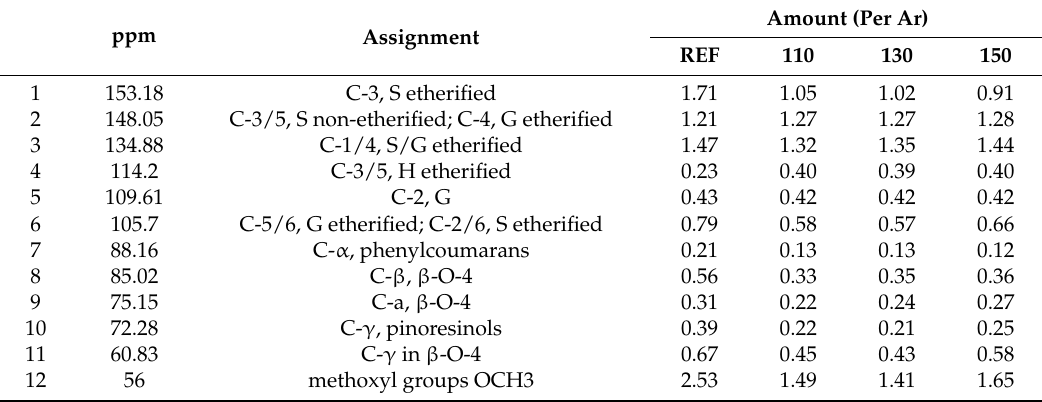
Table 4. Assignments of the Lignin 13 C Signals in the Spectra of the dioxane lignin.